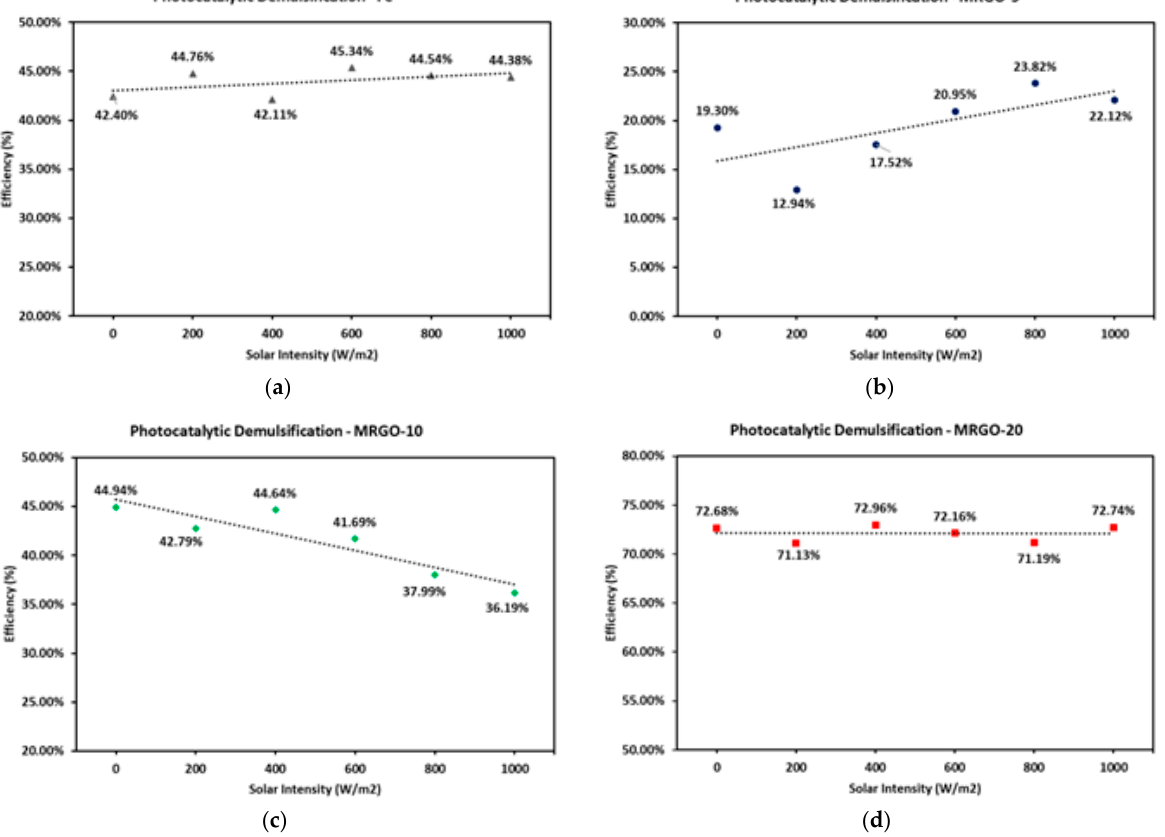
Figure 9. Photocatalytic demulsification using Fe and MRGOs under varying solar intensities.